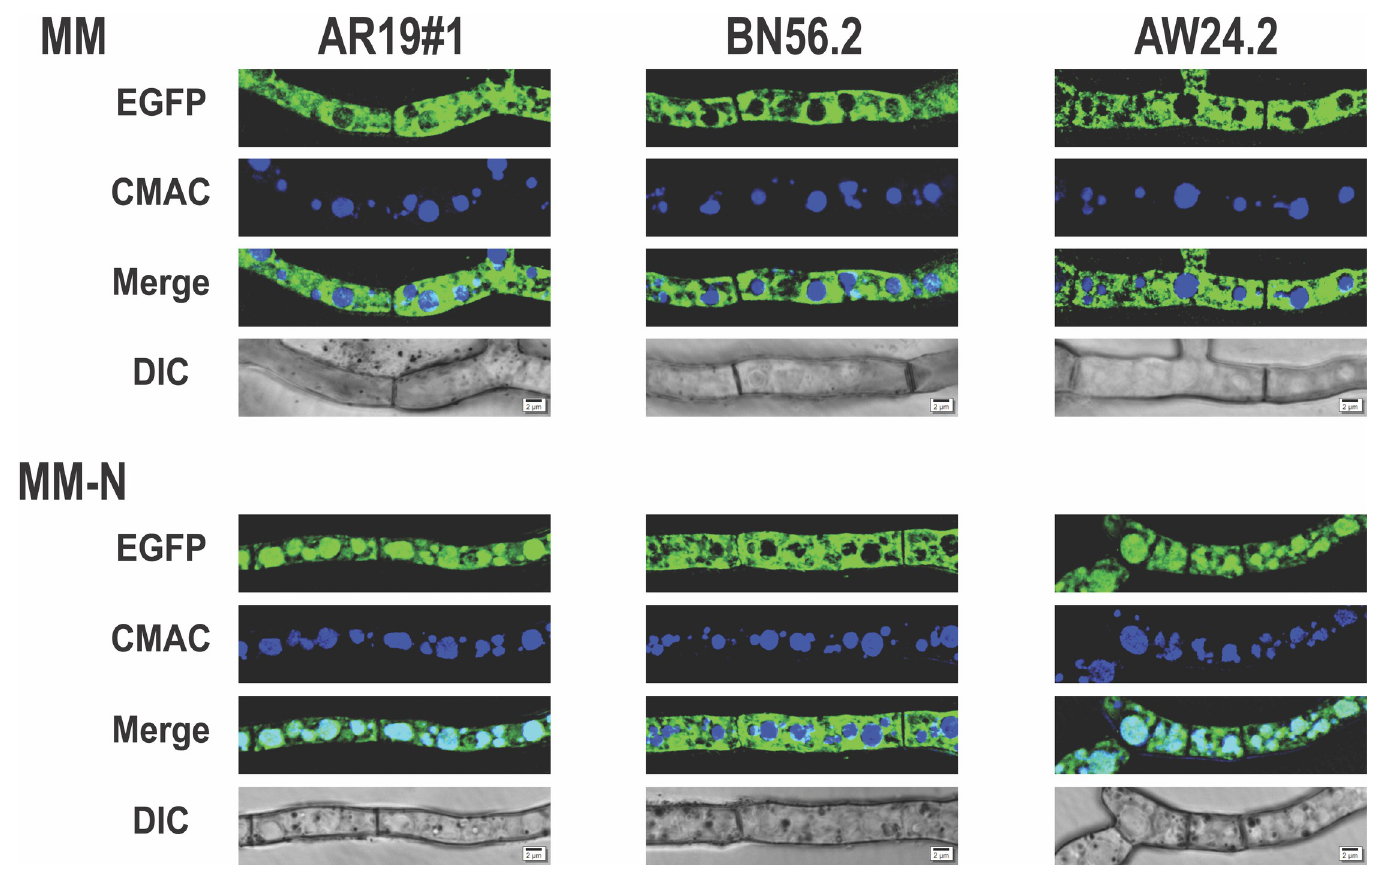
Fig 2. Autophagy response by nitrogen starved A . niger mycelia. The mycelia of A . niger strains AR19#1 (wild type), BN56.2 ( Δ atg1 ) and AW24.2 ( atg1 complemented) grown on MM till 20 h were transferred to MM-N. The EGFP fluorescence of mycelia after 4 h of N starvation is shown along with corresponding non-starved mycelia control. Each frame shows the image of an intermediate cell. The mycelia were stained with CMAC when vacuoles appear blue; the vacuoles containing EGFP appear cyan on merge (scale bar = 2 μ m).